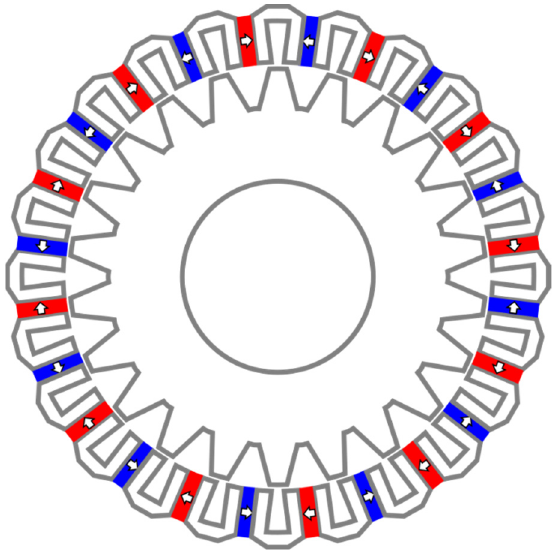
Figure 3. Switched flux permanent magnet machine for wind power generation [60].